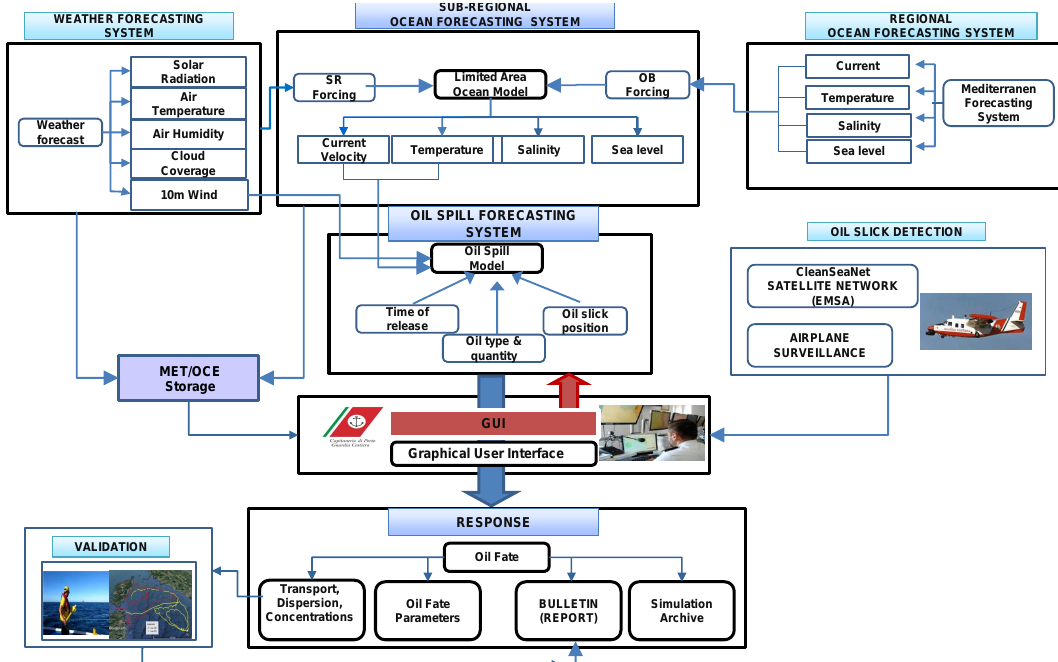
Figure 1. The figure shows the complex oil spill forecasting system, including the sub-regional ocean forecasting system, forced at the surface by heat and momentum fluxes using atmospheric parameters provided by the regional weather forecasting system, and at the boundary by the regional forecasting system. The graphical user interface (GUI), represented in Figure, is the tool to dialogue with such a system, which has as a result information about the transport and the fate of a hypothetical oil spill under Near-Real Time hydrodynamic